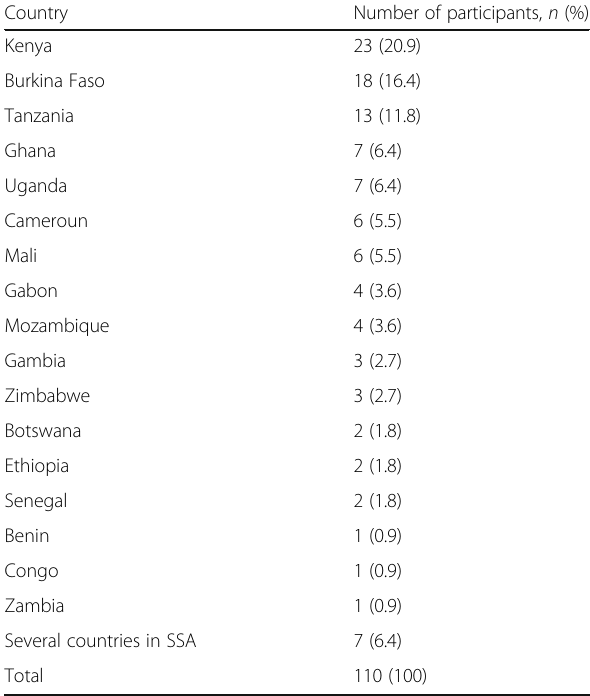
Table 4 Distribution of survey participants per country Country